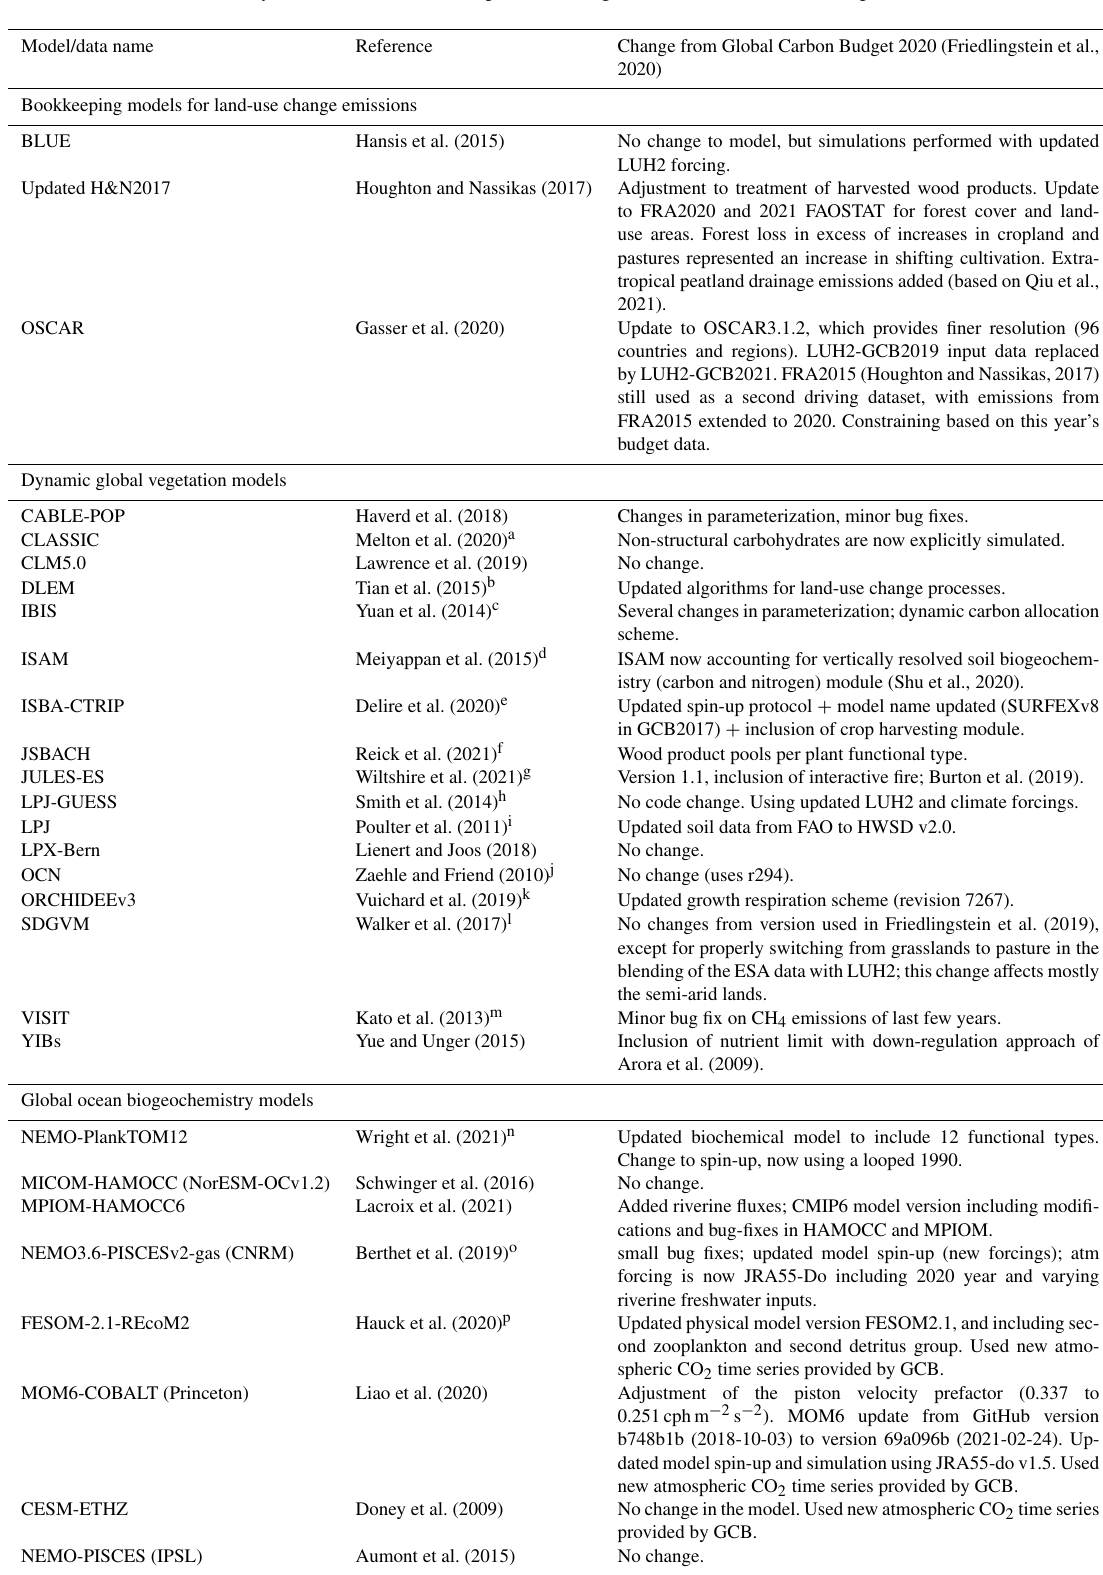
Table 4. References for the process models, f CO 2 -based ocean data products, and atmospheric inversions. All models and products are updated with new data to the end of year 2020, and the atmospheric forcing for the DGVMs has been updated as described in Sect.